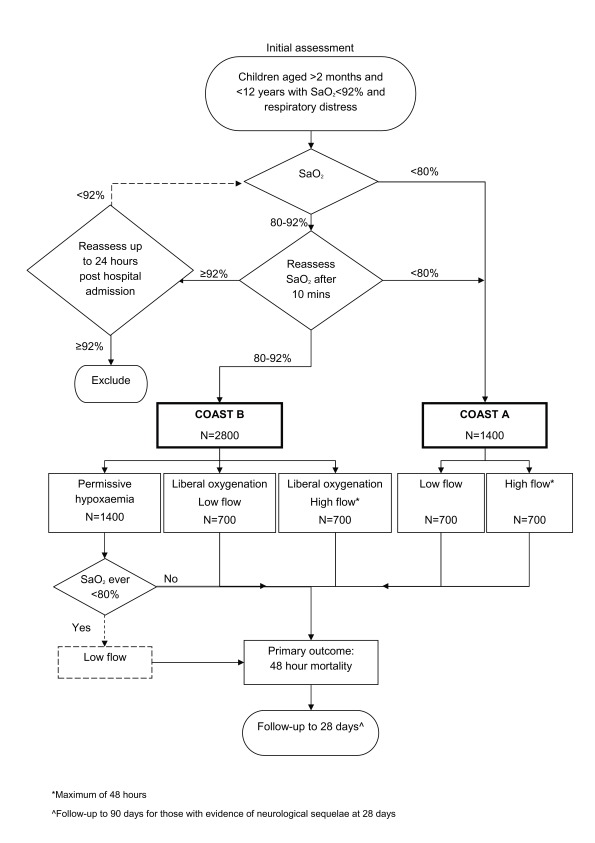
Trial flow chart.